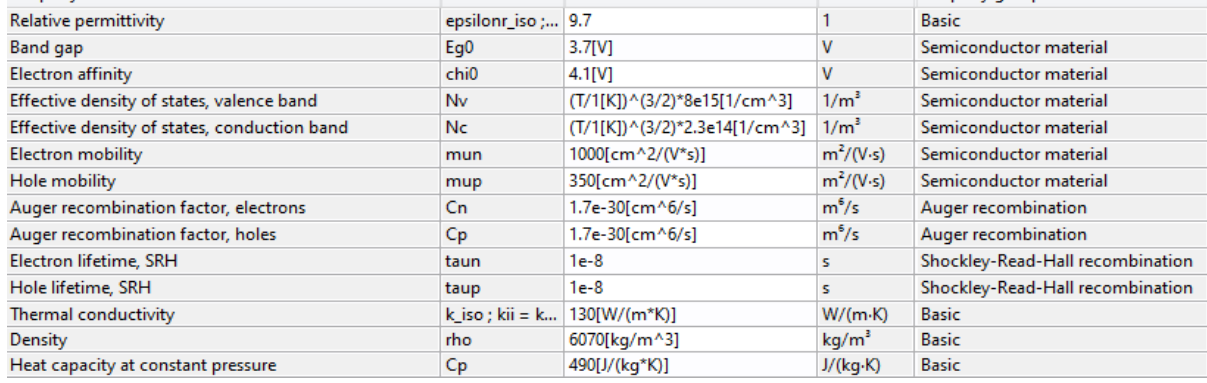
( b ) ( c ) ( d ) Figure 12. Summary of the physical parameters used in RBG study, using Comsol Multi-Physics Software Package. ( a ) GaN layer parameters for λ = 450 nm; ( b ) GaN layer parameters for λ = 525 nm; ( c ) GaN layer parameters for λ = 650 nm; ( d ) InGaN layer parameters.